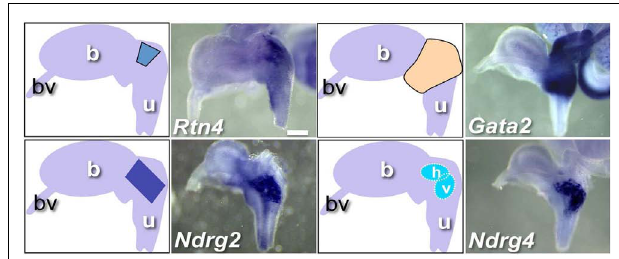
FIGURE 6 |WISH Gene expression patterns within and around fetal pelvic ganglia. Representative lateral views of individual gene expression patterns that exhibit distinct regional expression patterns within the pelvic ganglia are shown. Accompanying diagrams emphasize area of highest LUT expression detected for each gene. All images are 50 × magnification with a 300 µ m scale bar. Gene abbreviation/MGI gene ID/gender of sample: Rtn4 /1915835/male; Gata2 /95662/female; Ndrg2 /1352498/female; Ndrg4 /2384590/female. (b, bladder; bv, blood vessel; u, urethra; h, horizontal domain; v, vertical domain).